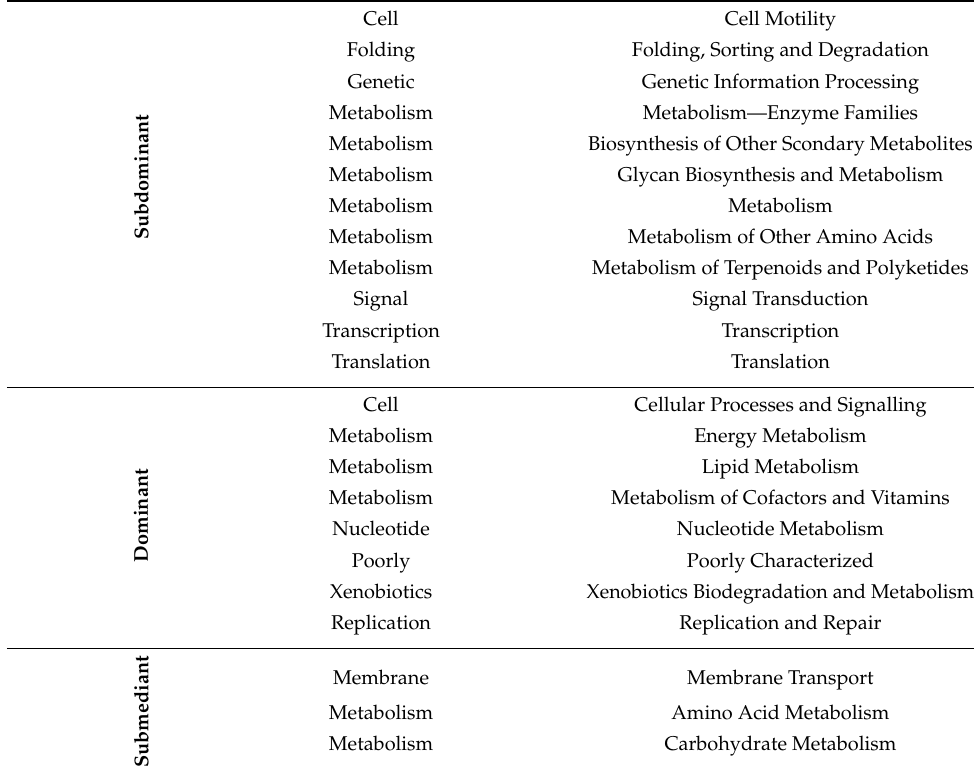
Table 3. Table describing the bacterial community functions divided into three groups: a. Subdomi- nant, b. Dominant, and c.